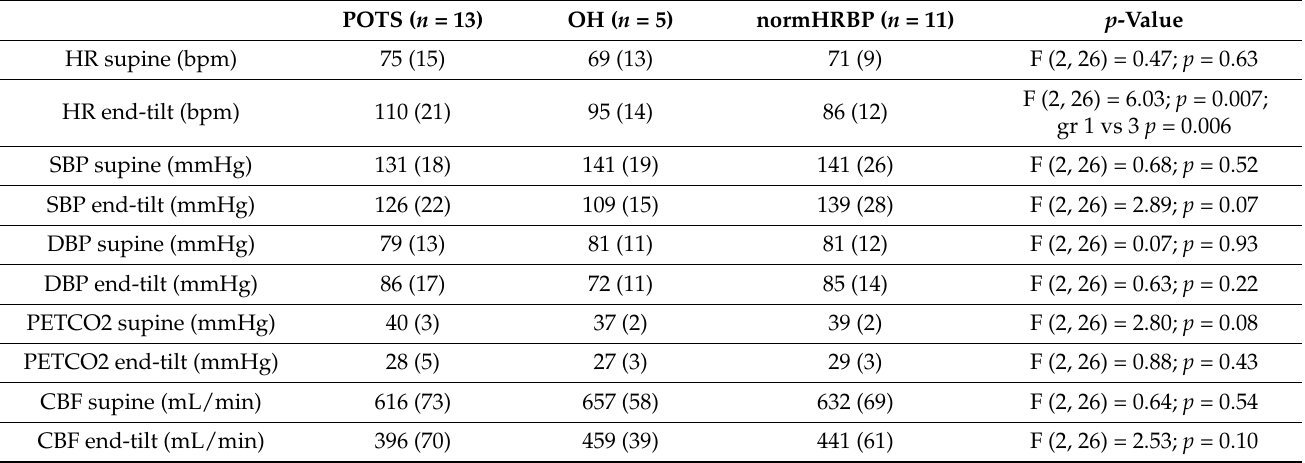
Table 2. Hemodynamic results of long-haul COVID-19 patients with POTS, with OH, and with a normal heart rate and blood pressure (normHRBP) during the tilt